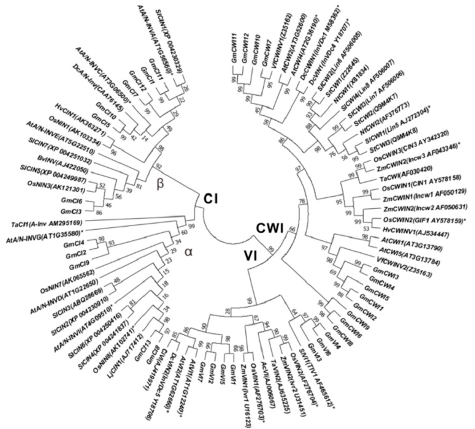
Figure 5. Phylogenetic relations of soybean invertase candidates with homologs from other plant species. Asterisks indicate genes that were functionally characterized by mutational studies. Phylogenetic tree was generated with Clustal alignment in MEGA 6 using neighbor-joining method.